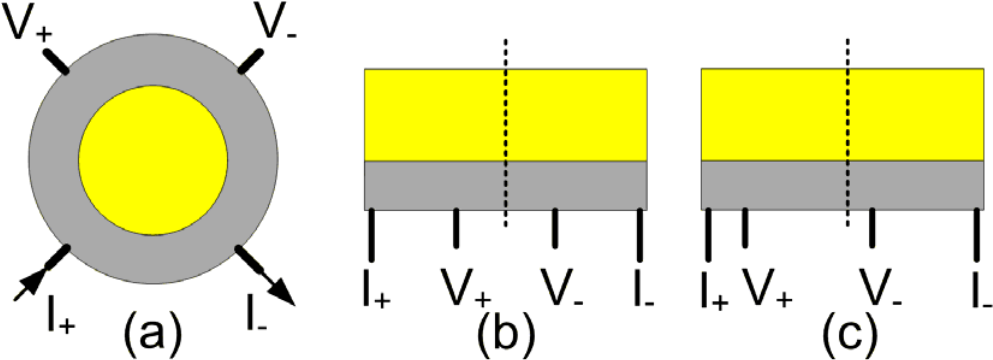
Figure 3. Sketches of the Extraordinary Magnetoresistance (EMR) devices with different geometries. ( a ) van der Pauw disc geometry; ( b ) symmetric bar geometry; and ( c ) asymmetric bar geometry. The dark lines labeled with I current leads and voltage probes, respectively. The dashed lines show the central axes of the bar-type devices. The gray blocks indicate semiconductor bulk material, and the yellow blocks indicate metal